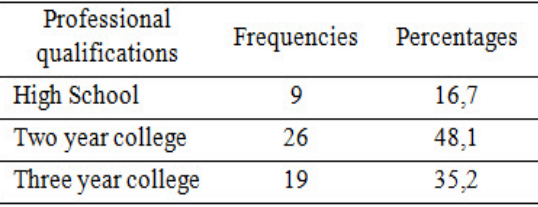
Table 1. Structure of the sample in rela - tion to the qualifications of the respondents